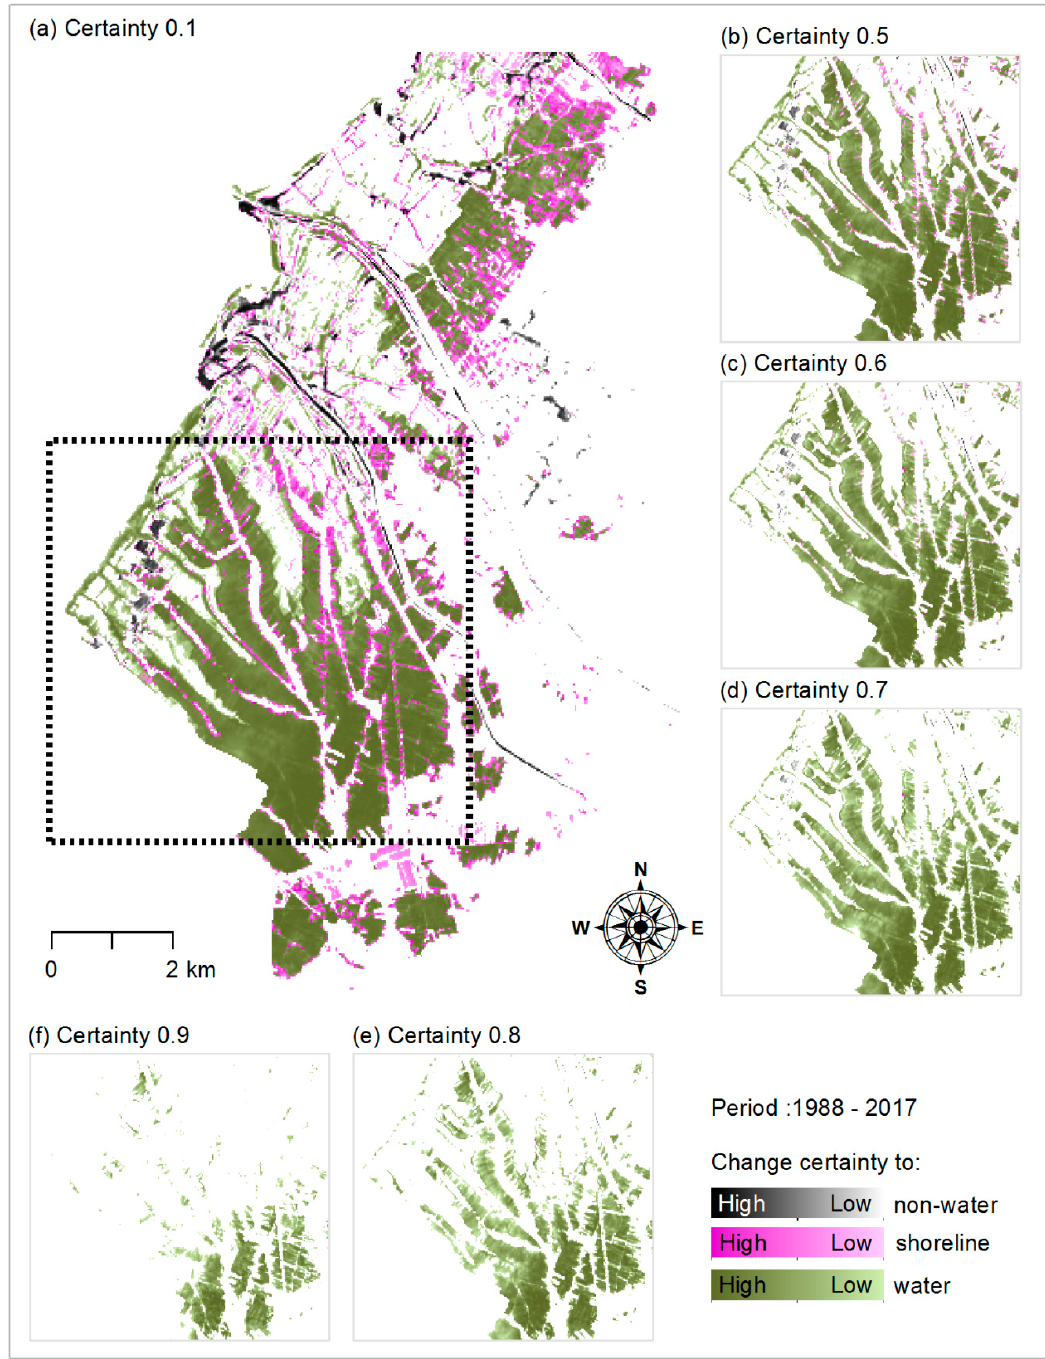
Figure 18. ( a ) Change certainty of non-water , shoreline margin and water for the period 1988 up to 2017 in east section. ( b – f ) The change area is decreasing by the increase of certainty level.